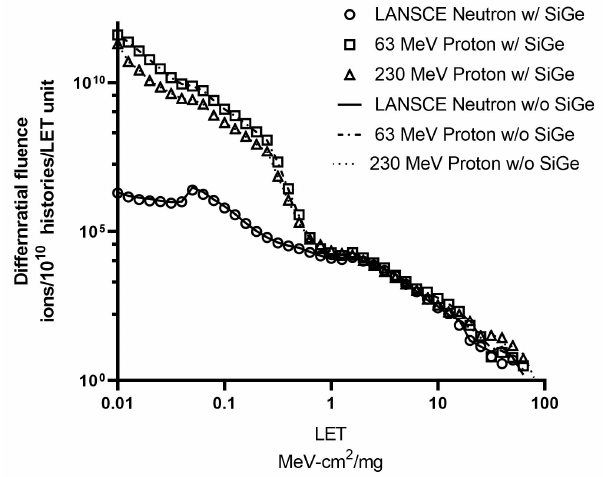
Figure 7. LET spectra of the structure with and without SiGe irradiated by 63 and 230 MeV protons and LANSCE neutron. The plot is in log-log scale.